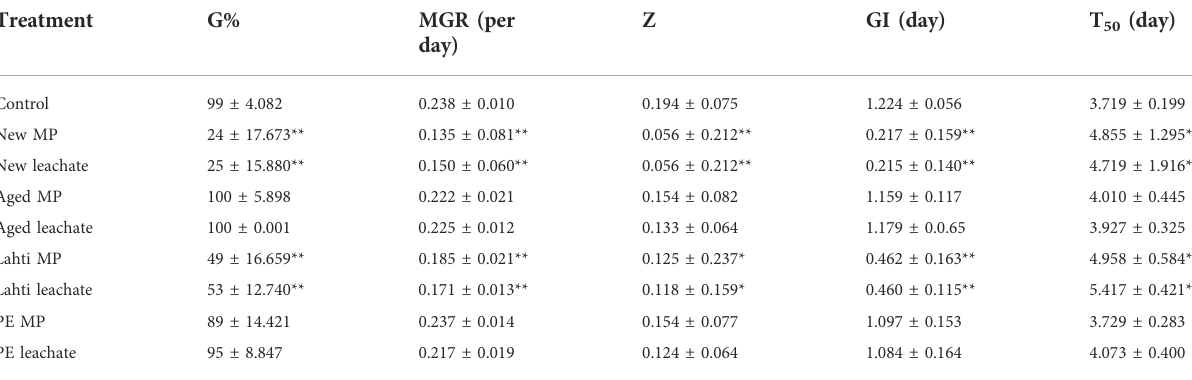
TABLE 1 Calculation of parameters related to germination; germination percentage (G%), mean germination rate (MGR), synchronization index (Z), germination index (GI), and 50% germination time (T 50 ), expressed as mean ± standard deviation ( n = 24).